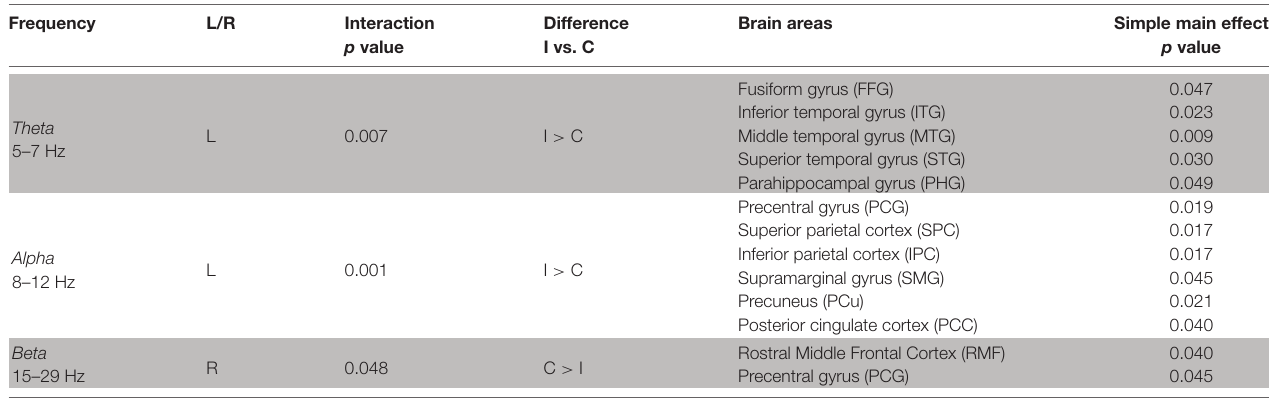
TABLE 1 | Multi-finger task repeated measures analysis of variance (RM ANOVA) results summary.